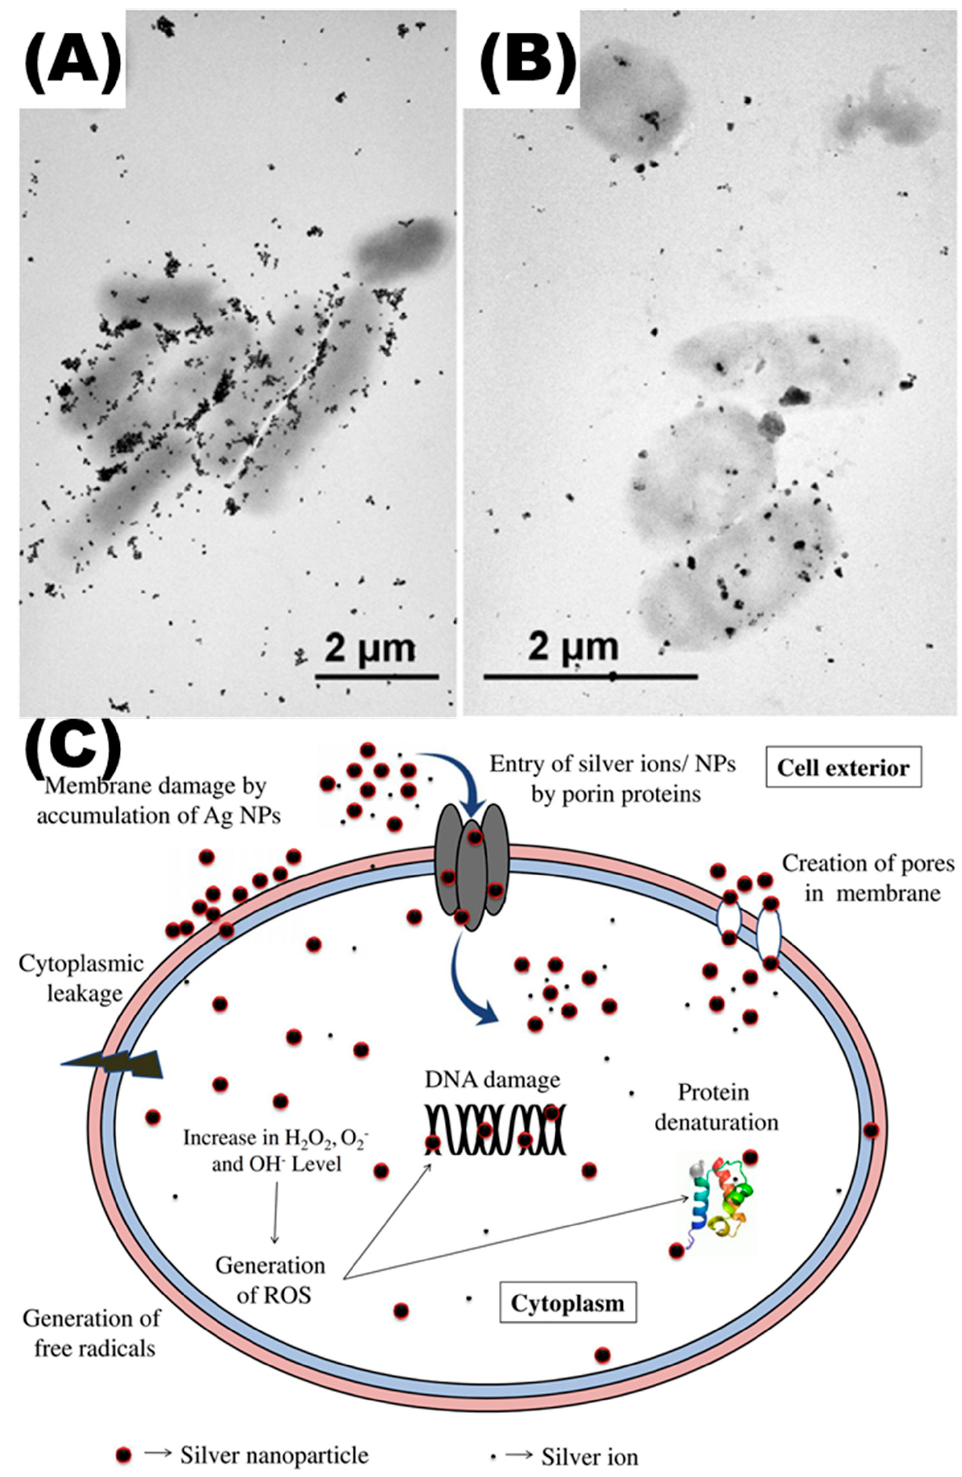
Figure 3 . Effects of Ag NPs on gut microbiota. ( A , B ) The TEM images of E. coli co-incubated with